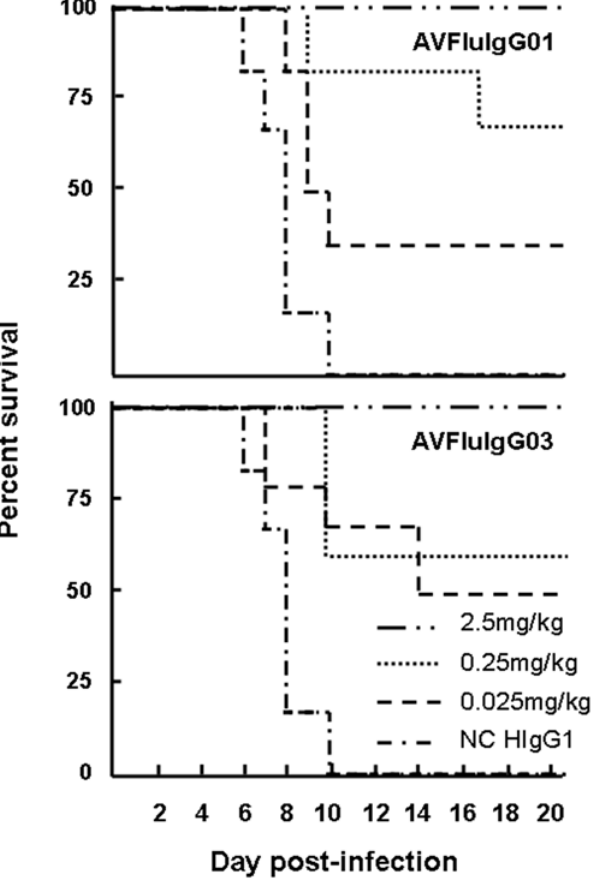
Figure 2. Protective efficacy of AVFluIgG01 and AVFluIgG03 in mice. BALB/c mice (n=6 per group) were passively immunized by i.p. injection of graded doses of rhAbs, AVFluIgG01 or AVFluIgG03, or human IgG1 (HIgG1) as a negative control (NC). Mice were challenge i.n. with 50 m l of 10 LD 50 (=10 4 MID 50 ; 10 5.5 EID 50 ) of AH/1/05 virus 24 h later. The data show the Kaplan-Meier survival curves for the 21 days p.i. Mice that received 2.5 mg/kg of either AVFluIgG01 or AVFluIgG03 were completely protected from a lethal challenge (rhAbs versus HIgG1, p=0.0006 , log rank test). Both rhAbs also afforded partial protection and delayed days to death at lower doses of 0.25 mg/kg and 0.025 mg/ kg (rhAbs versus HIgG1, p , 0.05 , log rank test).